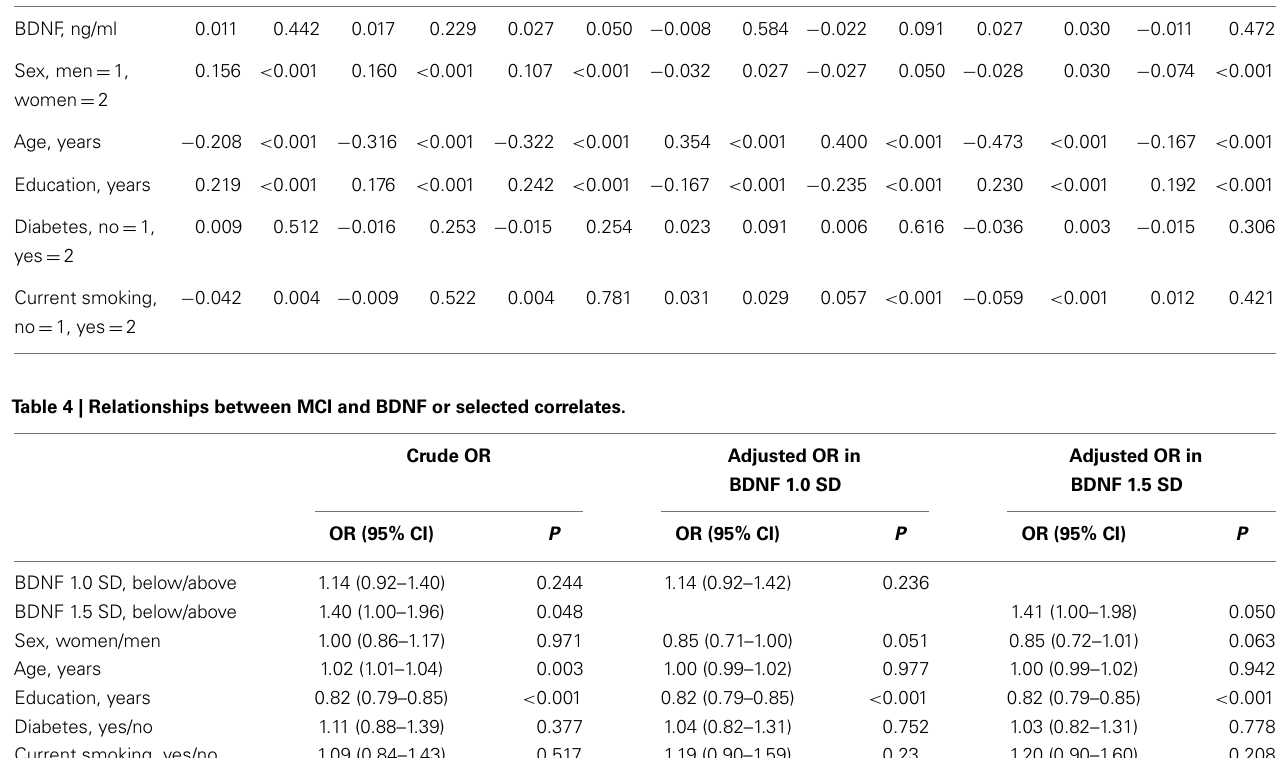
Table 3 | Multiple linier regression analyses with serum BDNF, potential confounders, and cognitive tests. Independent